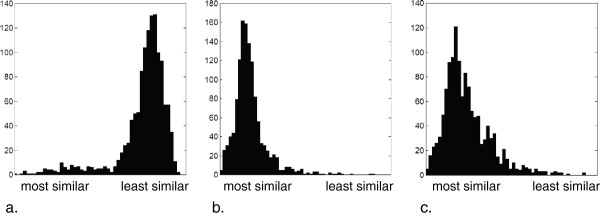
Illustrated are histograms of the similarity measures for the 1275 comparisons. Provided are results for (a.) MFP, (b.) NN and (c.) DGA.